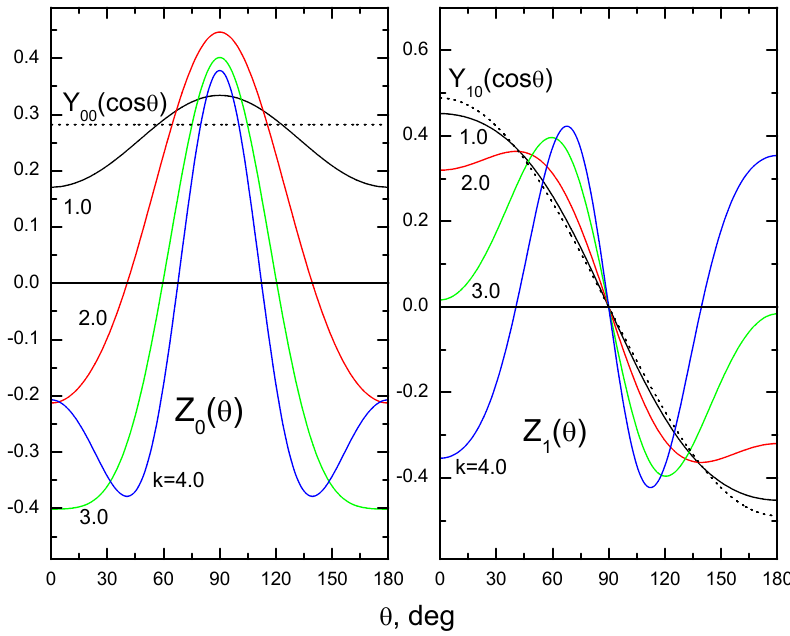
Figure 2. The “characteristic amplitudes” (20) as functions of the angle θ